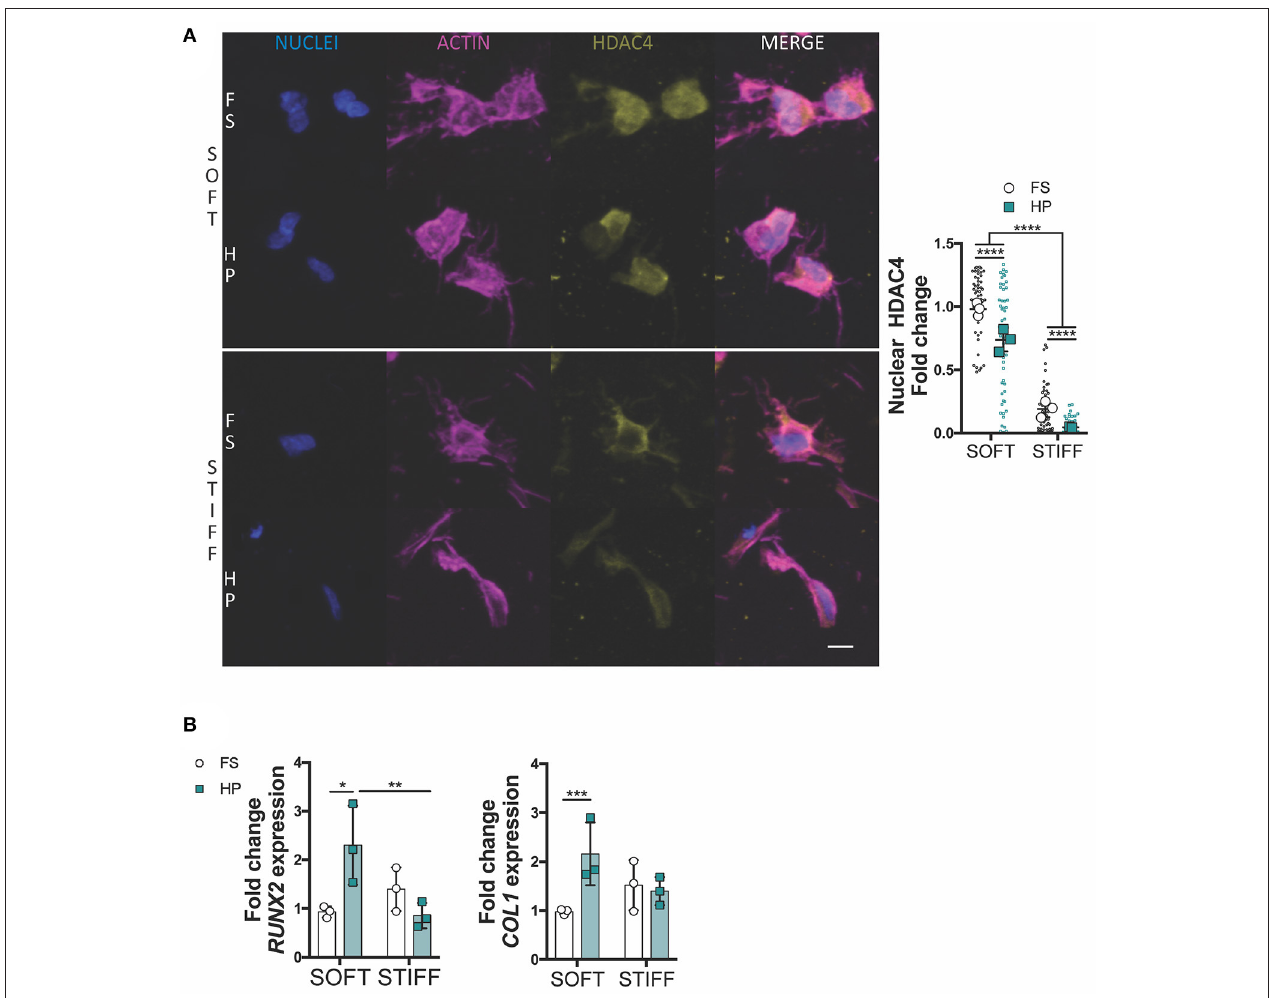
FIGURE 4 | HDAC4 nuclear localization in MSCs is responsive to HP stimulation. (A) Evaluation of HDAC4 localization and nuclear content. Cells stained for nuclei (blue), actin (magenta) and HDAC4 (yellow). Scale bar, 10 µ m. (B) Day 7 gene expression relative to SOFT FS group. * p < 0.05, ** p < 0.01, *** p < 0.001, **** p <